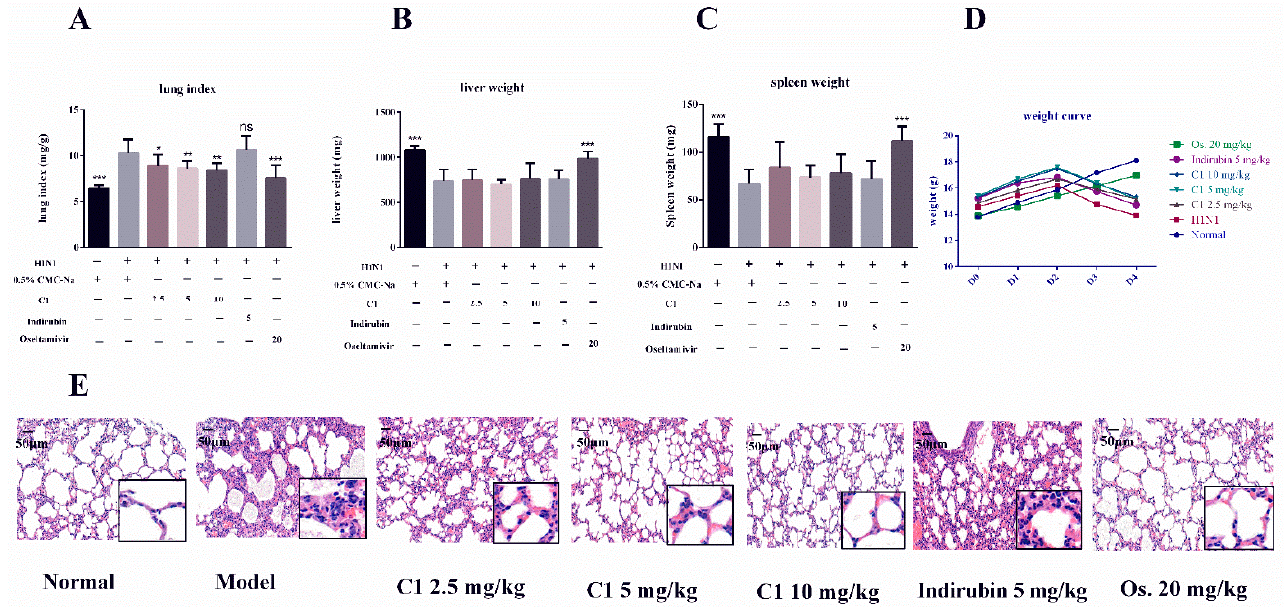
Figure 3. The protective effects of C1 on lung injury, lung index, organ weight and body weight. Mice were infected with 3L 50 of the H1N1 virus and administered orally with C1, indirubin, oseltamivir or 0.5% CMC-Na at indicated doses once daily for four days. Lung index, liver weight, spleen weight and mice body weight were detected and calculated. Hematoxylin-eosin stain (H&E) with different visions ( A ) lung index = lung weight (mg) body weight (g) × 100%, ( B ) weight of liver, ( C ) weight of spleen, ( D ) body weight change curve ( n = 42), ( E ) H&E staining, photographed at 200× and 400× magnification. Data are expressed as mean ± S.D. * p < 0.05, ** p < 0.01, *** p < 0.001, compared with model group.